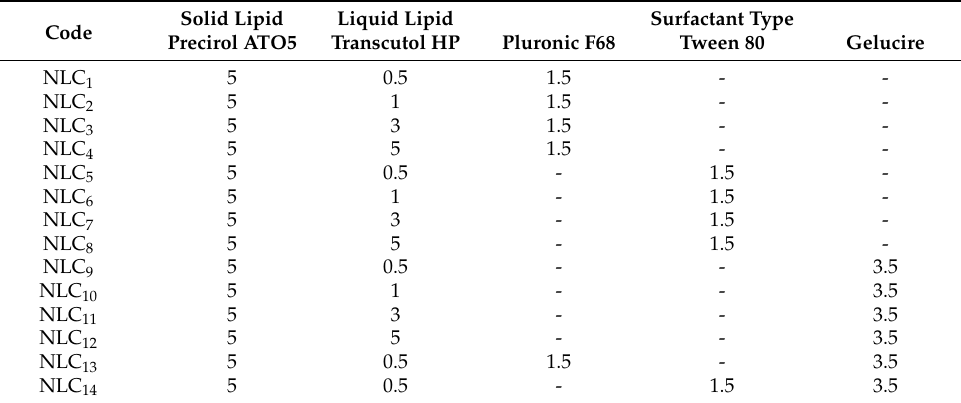
Table 3. Composition (% w/w ) of the different NLC colloidal dispersions in water. Solid Code